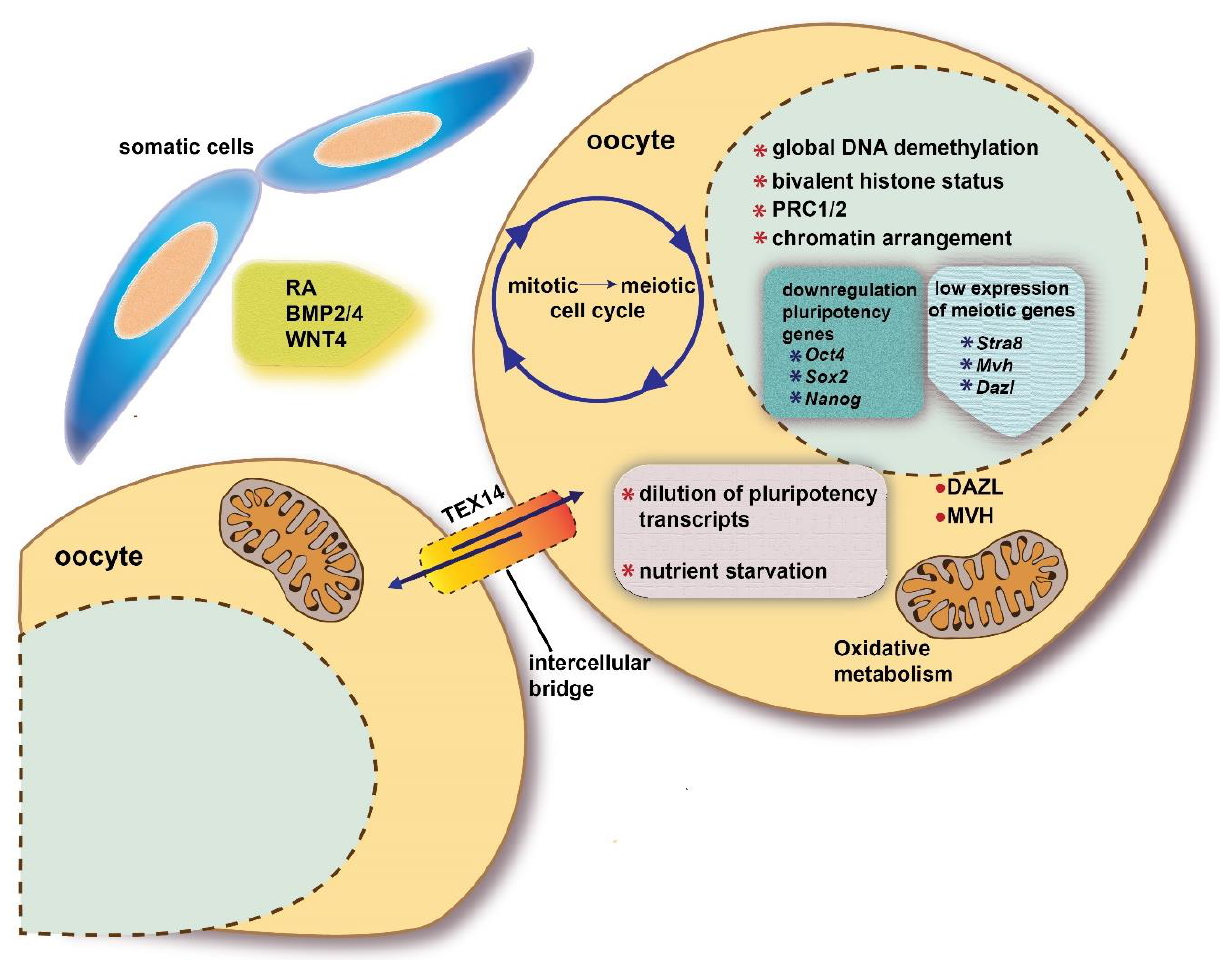
Figure 2. Schematic representation of intrinsic and extrinsic factors discussed in the present review involved in the beginning of meiosis in a fetal oocyte.